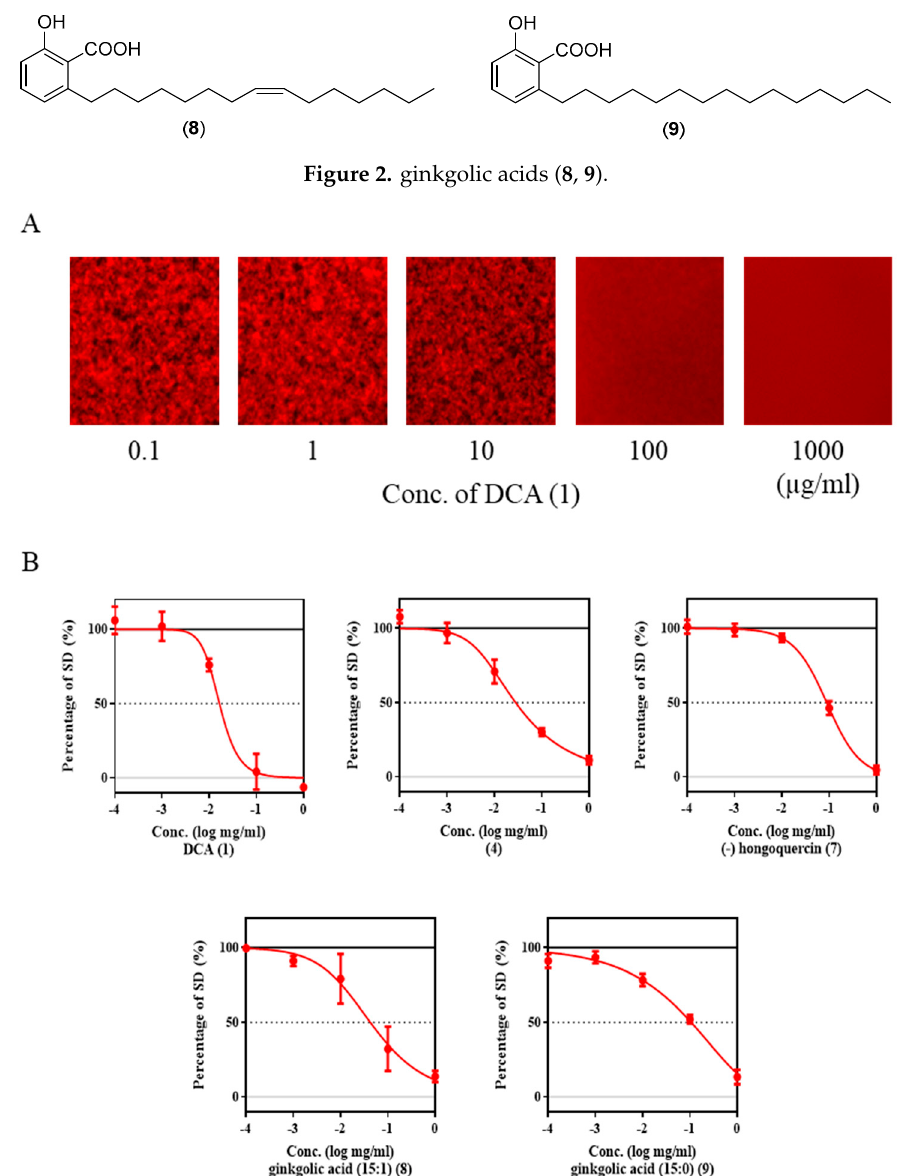
Figure 3. ( A ) Inhibition of A β 42 aggregation by DCA, its derivatives, and natural sphingomyelin synthase inhibitors, as shown by incubation of 30 nM QDA β and 30 µ M A β with various concentrations of these compounds. ( B ) Estimation of EC 50 values from inhibition curves, in which the percent SDs of fluorescence intensities were plotted against the concentrations of these compounds.